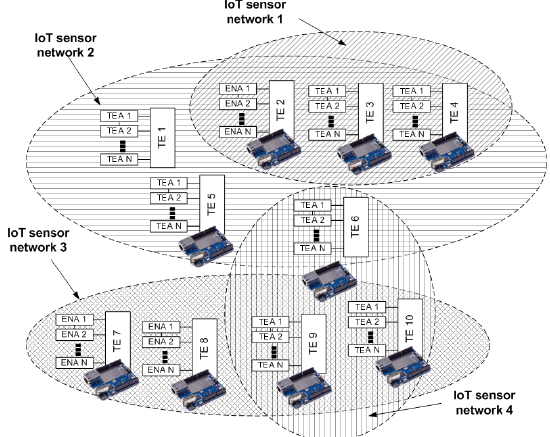
Figure 2. Hybrid executor node layer composition in an IoT